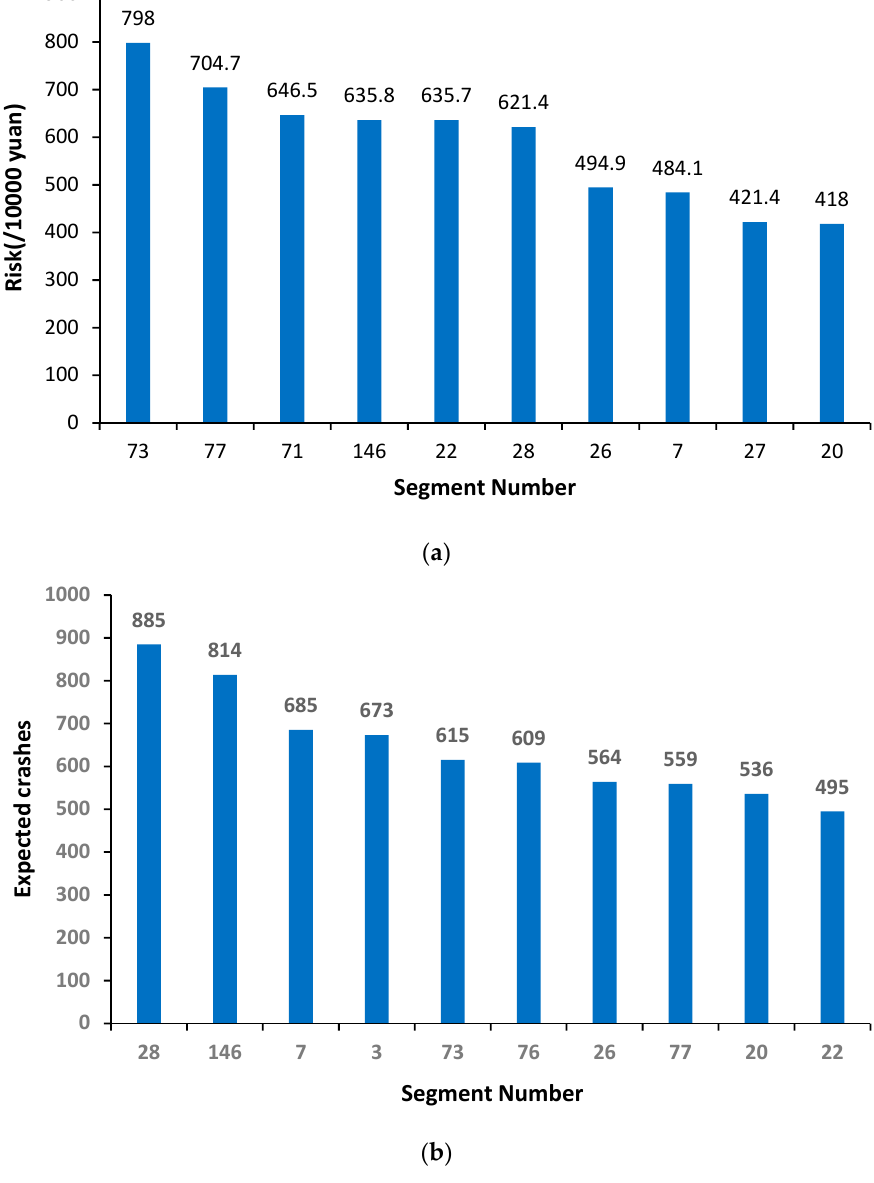
Figure 7. Top 10 hotspots based on quantitative risk assessment (QRA) and empirical Bayesian (EB). ( a ) top ten hotspots based on risk assessment; and ( b ) top ten hotspots based on the EB method.